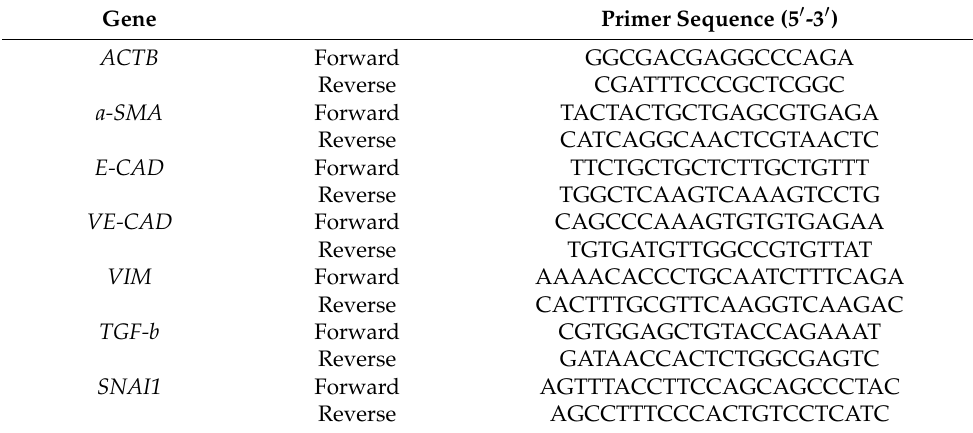
Table 2. Primer sequences used for reverse Real-Time